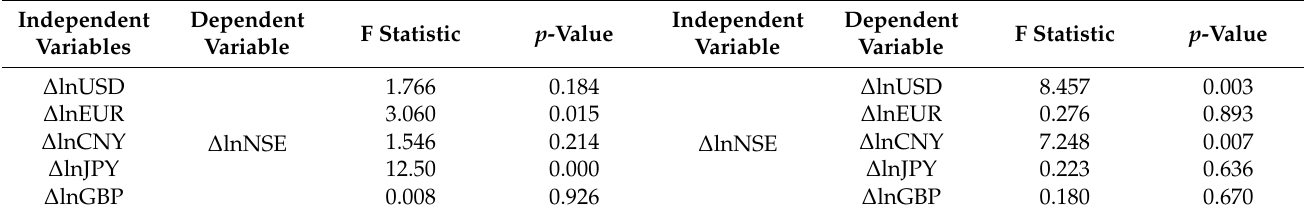
Table 4. Granger causality in VAR Framework for the period September 2005–September 2009.